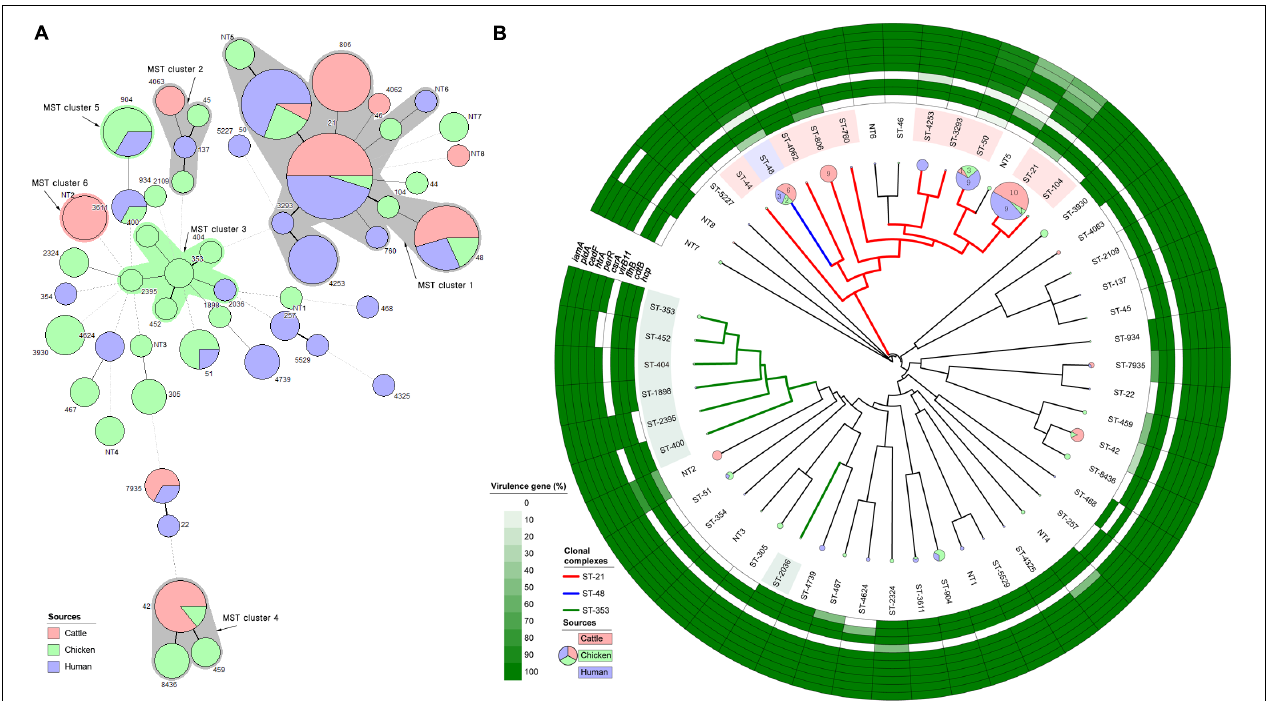
FIGURE 3 | Clonal distribution analysis of C. jejuni isolates from all three sources. (A) Minimum spanning tree based on MLST data from 146 strains. Each number represents a sequence type, and the size of the node indicates the number of strains belonging to the ST (red: cattle, green: chicken, and purple: human). A bold solid line indicates that there is one allele difference between STs, and a thin solid line indicates that two and three alleles are different according to the length. Four to six allele differences are represented by a wide-interval dotted line, and seven are indicated by a narrow-interval dotted line. Nodes with fewer than two different alleles have been placed in the same cluster. Each cluster contains at least five entries and at least one node. The number shows the sequence type of each node. The color of the shadow represents the major source of the cluster, while a gray shadow indicates no primary source. (B) UPGMA dendrogram based on 51 different STs identified through MLST in a total of 146 strains, and detection rate of 10 virulence-associated genes of C. jejuni belonging to each ST. Pie chart shows the number of strains belonging to each ST (red: cattle, green: chicken, and purple: human), and the major CC is indicated by a thick, solid, colored line and the ST background color. In addition, the positivity rates of pathogenicity-associated genes in the strains belonging to each ST are